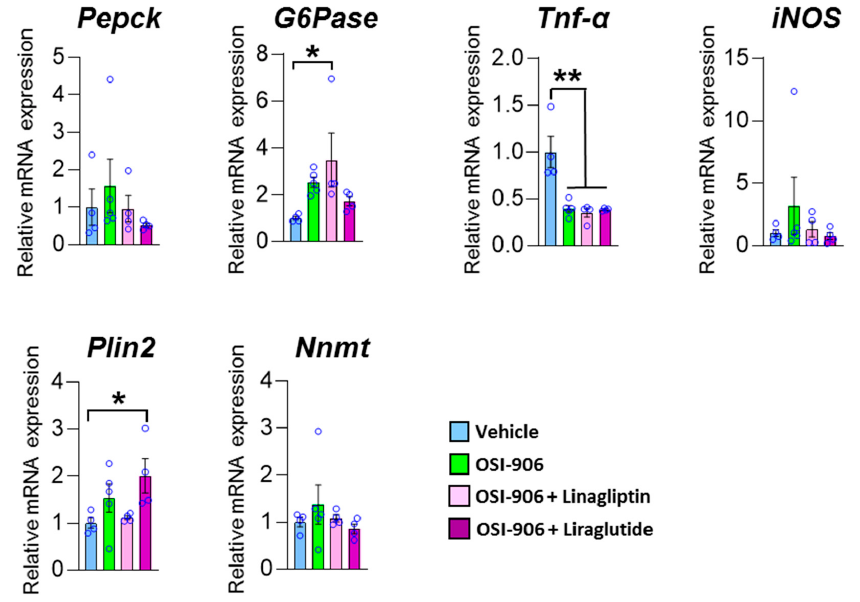
Figure 8. Impact of linagliptin or liraglutide on gene expressions in OSI-906-treated AML-12 cells. The gene expressions of the indicated genes in AML-12 cells treated with 10 nM linagliptin or 100 nM liraglutide in the presence of 200 nM OSI-906 are shown. Cells were serum-starved overnight and then incubated with OSI-906 for 4 h before the treatment with linagliptin or liraglutide. Then, the cells were incubated for 24 h with the indicated drugs. Data represent the mean ± SEM. * p < 0.05, ** p < 0.01 ( n = 4–5 per group) by ANOVA with an additional Tukey–Kramer post-hoc test.